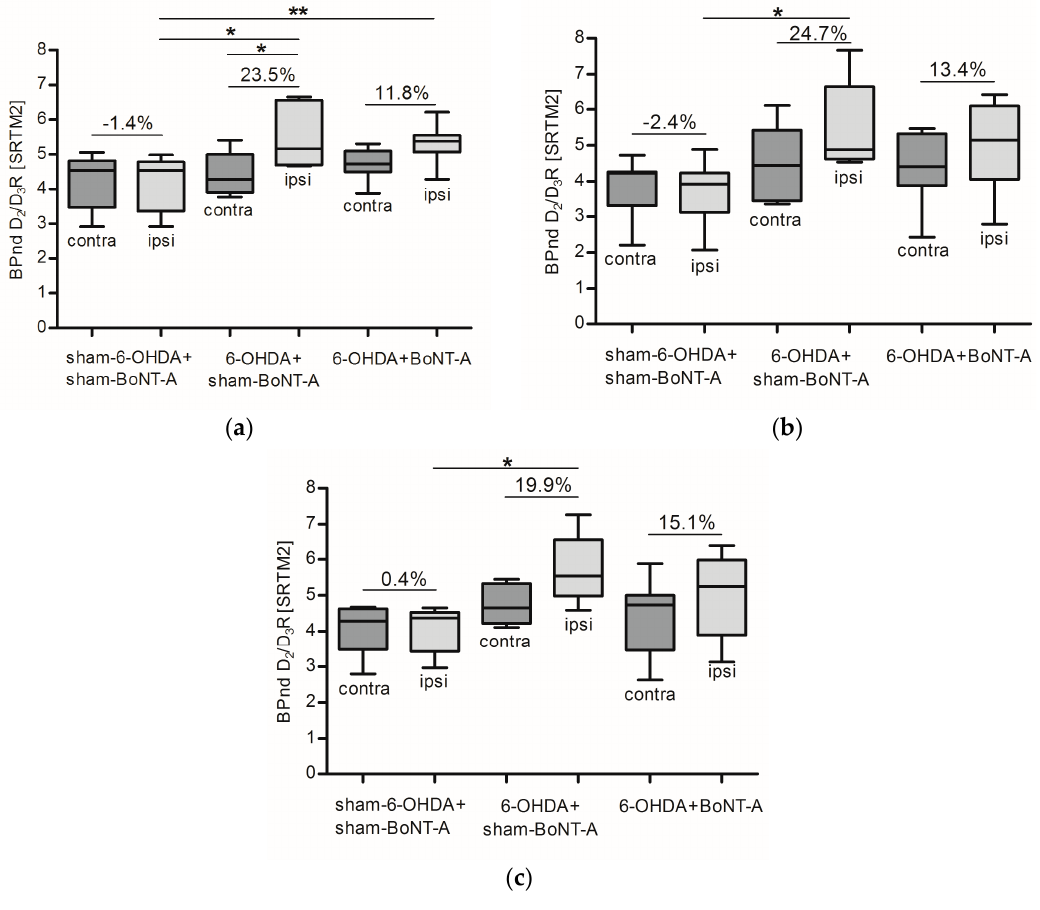
Figure 4. Box plots for BP nd values of D 2 /D 3 R depicting median and interquartile ranges separately for the contralateral (dark grey) and ipsilateral (light grey) CPu for controls (sham-6-OHDA + sham-BoNT-A), sham-injected hemi-PD rats (6-OHDA + sham-BoNT-A) and BoNT-A-injected hemi-PD rats (6-OHDA + BoNT-A) ( a ) one month, ( b ) three months, and ( c ) six months post-BoNT-A or -sham-BoNT-A injection. D 2 /D 3 R availability was consistently symmetric in controls, increased in sham-injected hemi-PD rats at all analyzed time points and was reduced to nearly normal values after BoNT-A injection in hemi-PD rats. Significance is displayed as * p < 0.05, ** p < 0.01.